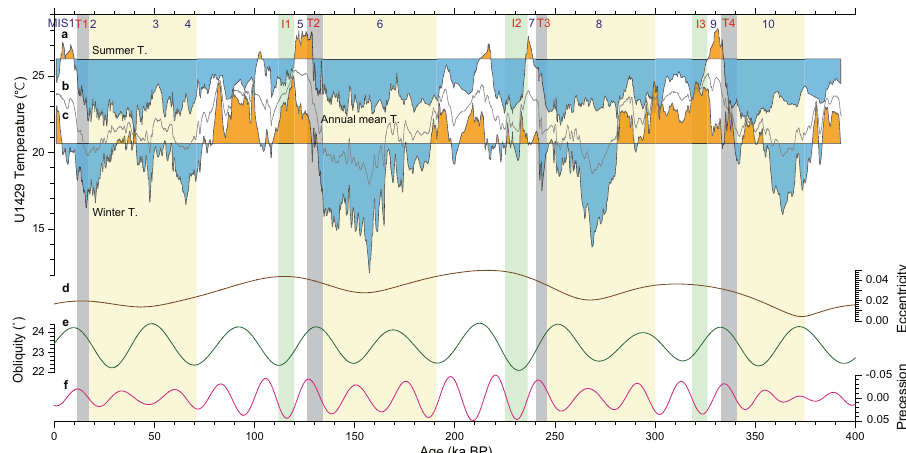
Fig. 5 Time series of annual mean and seasonal sea surface temperatures (SST) and orbital parameters. a Mg/Ca-based summer SST ( T S ) at site U1429, b alkenone-based annual mean SST ( T A ), c calculated winter SST (T W = 2T A - T S ), d eccentricity, e obliquity, and f precession. Three temperature time series are plotted on the same temperature axis. The horizontal line indicates the Holocene mean SST at Site U1429 for the summer and winter temperature time series. Orange and blue shaded areas indicate the values above and below the mean value, respectively, for summer and winter SSTs. Yellow, grey, and green shaded areas indicate the glacial period, termination, and inception, respectively. Glacial inception periods are denoted as I1, I2, and I3 3 , and glacial termination periods are indicated as T1, T2, T3, and T4 23